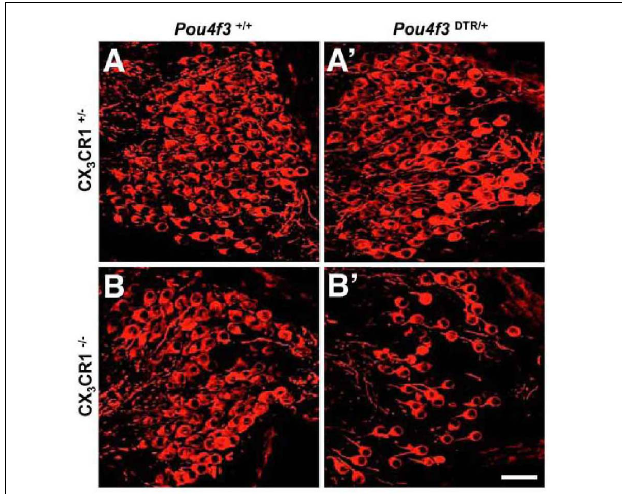
FIGURE 4 | CX3CR1 deficiency leads to significant SGN loss after HC ablation. (A) CX3CR1C + / – mice without DT, (B) CX3CR1 – / – mice without DT, (A (cid:48) ) CX3CR1C + / – mice at 56 days after DT, (B (cid:48) ) CX3CR1 – / – mice at 56 days after DT. Compared with CX3CR1C + / – mice, significant SGN loss in cochlear mid-modiolar sections of CX3CR1 – / – mice was observed. No SGN loss was seen in Pou4f3 + / + mice that were either CX3CR1 – / – or CX3CR1C + / – . Neurons (neurofilaments) are in red. Scale bar = 30 µ m [citing from Kaur et al.